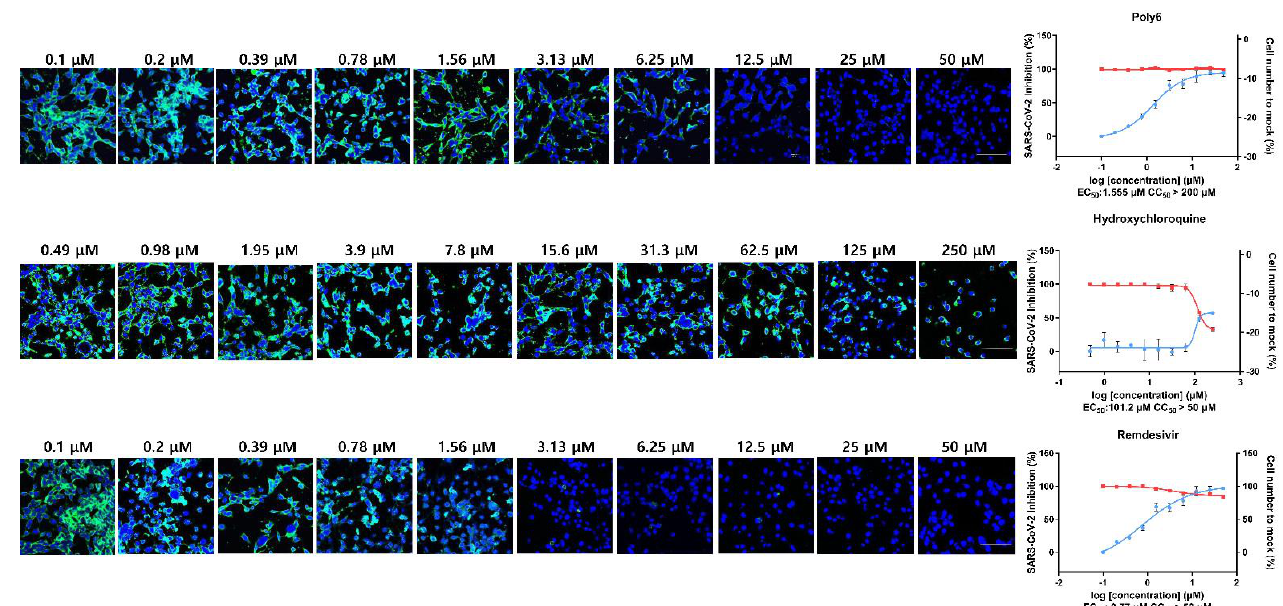
Figure 2. Immunofluorescence and dose–response curve analysis of Poly6 and reference drugs. Poly6 and two reference drugs, remdesivir (RDV) and hydroxychloroquine sulfate (HCQ), were serially diluted to 10 concentrations ranging from 0.1 to 50 µ M for Poly6 and RDV and 0.47 to 250 µ M for HCQ. SARS-CoV-2 infectivity and the inhibition capacity of each drug were measured by immunofluorescence of NP. EC50 and CC50 are indicated under each graph. Nuclei are shown in blue, and NP is shown in green (Alexa 488). Graphs on the right panel of the images: the blue line shows the percent infectivity of SARS-CoV-2 in treated cells compared to the control group, and the red line indicates cell number in treated cells compared to mock-treated cells in percentage (%). Scale bars: 100 μ m.